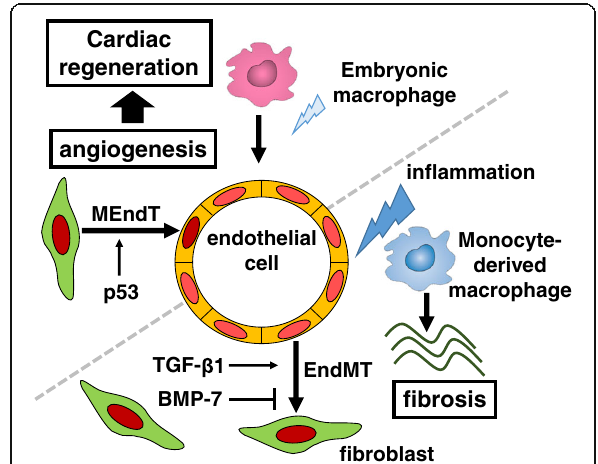
Fig. 3 Angiogenic and fibrogenic responses during cardiac tissue injury and repair. Both MEndT and EndMT actively contribute to cardiac angiogenesis and fibrosis after cardiac injury. Embryonic macrophages can promote angiogenesis and subsequent cardiac regeneration in neonatal mice after cardiac injury, but infiltrate macrophages during adult cardiac injury do